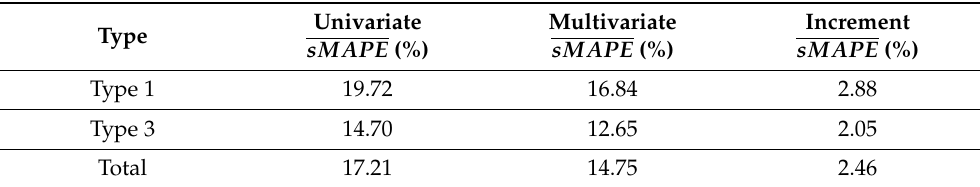
Table 7. Comparison of the results of energy consumption forecasting with a RNN that uses the information of the SMs belonging to each spatial subgroup (5 variables) and a RNN that only uses the historical information of the SM itself (1